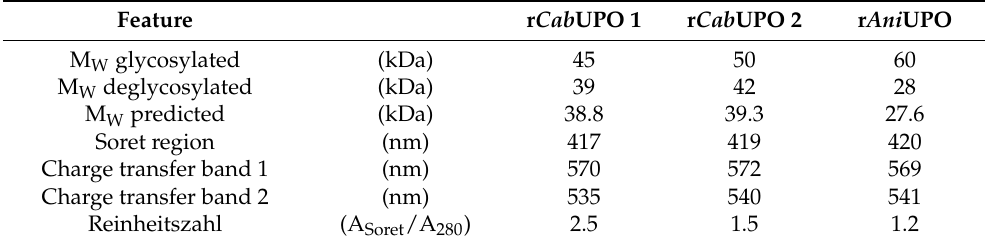
Table 3. Size and spectroscopic characteristics of r Cab UPO 1, r Cab UPO 2, and r Ani UPO. Molecular mass of glycosylated and deglycosylated UPO proteins were calculated from Figure 5. Molecular weights of the mature proteins, i.e., excluding the N-terminal secretion signal, were predicted using SignalP 5.0 [28].